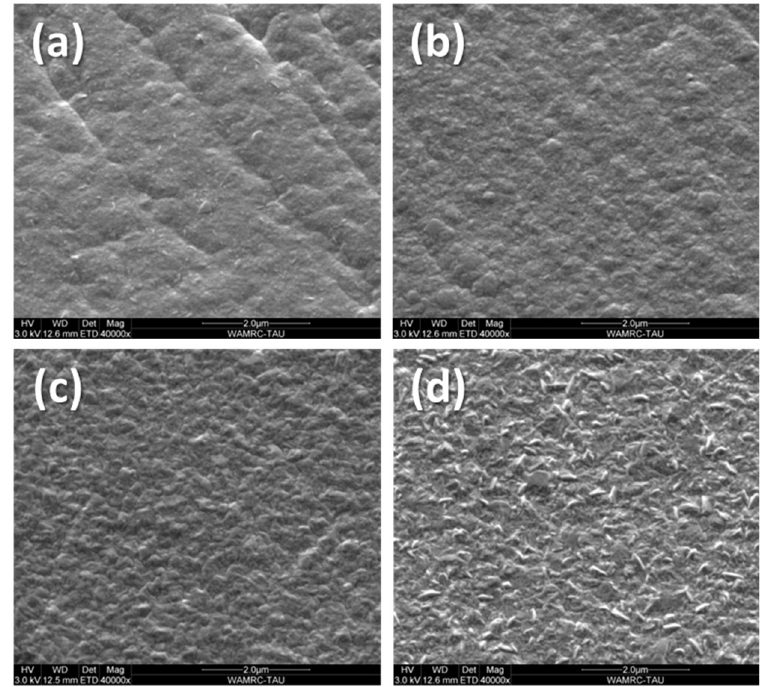
Figure 1. Scanning electron microscopy (SEM) images of Pd films deposited at 3 mA/cm 2 (a) 20% duty cycle (b) 35% duty cycle (c) 50% duty cycle (d) DC (100% duty cycle).